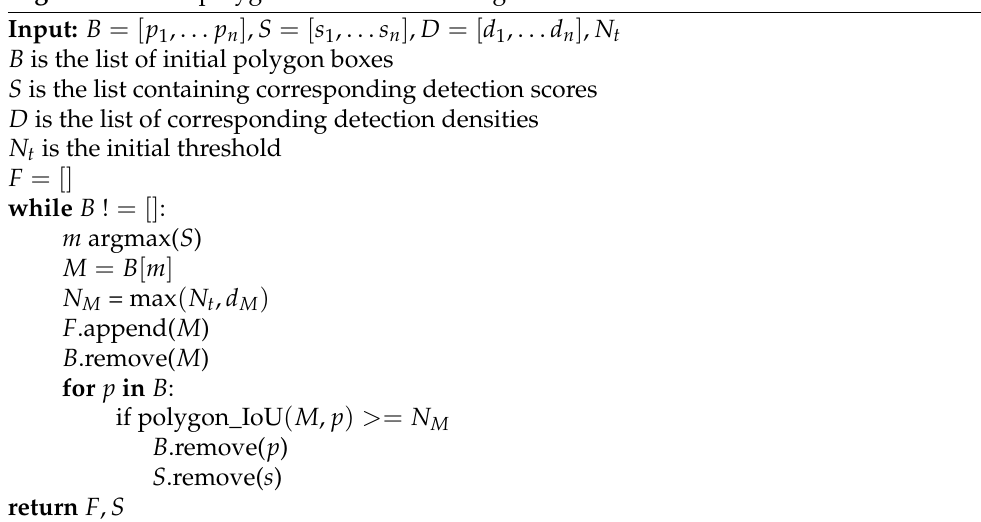
Algorithm 1 The polygon-based PA-NMS